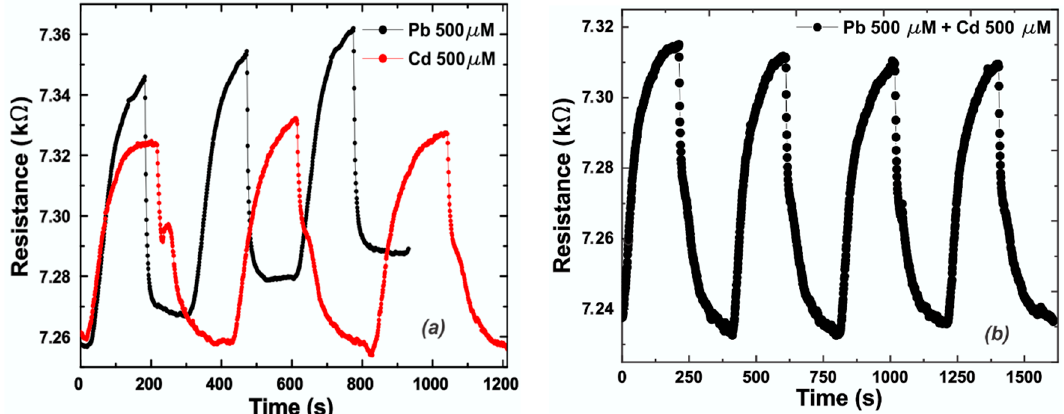
Figure 4. ( a ) Comparison between epitaxial graphene (EG) responses (resistance) to a concentration of 500 µM of Pb 2+ (black line) and Cd 2+ (red line) versus time; ( b ) EG response to a complex sample in which both solutions of Pb 2+ and Cd 2+ with a concentration of 500 µM were mixed.